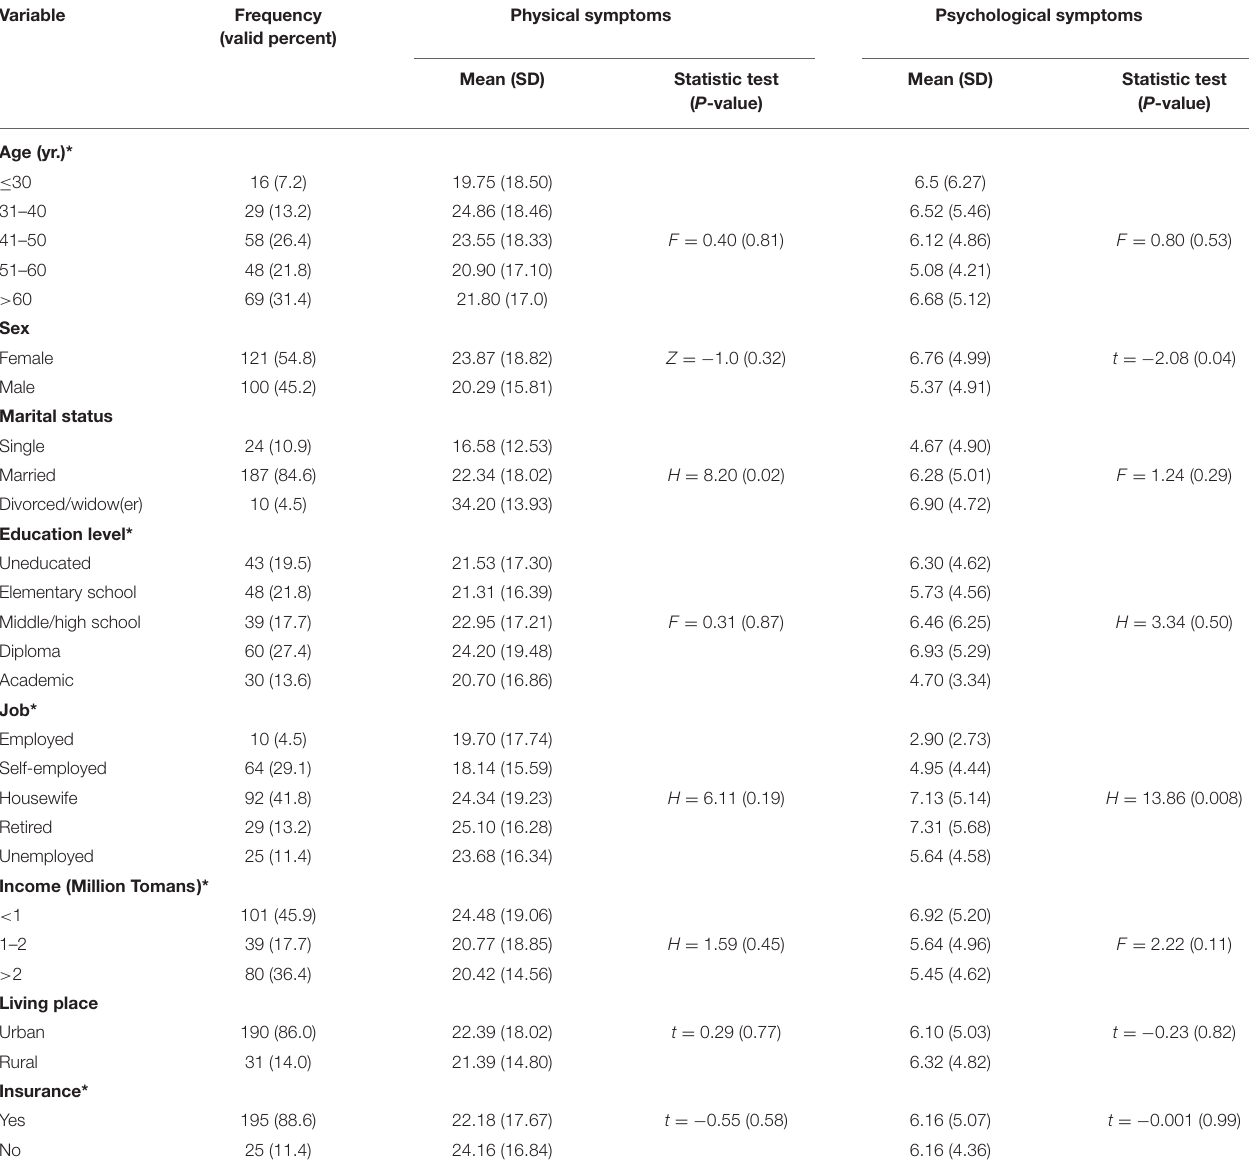
TABLE 1 | Demographic characteristics of the participants and psychosomatic symptoms differences among the participants.